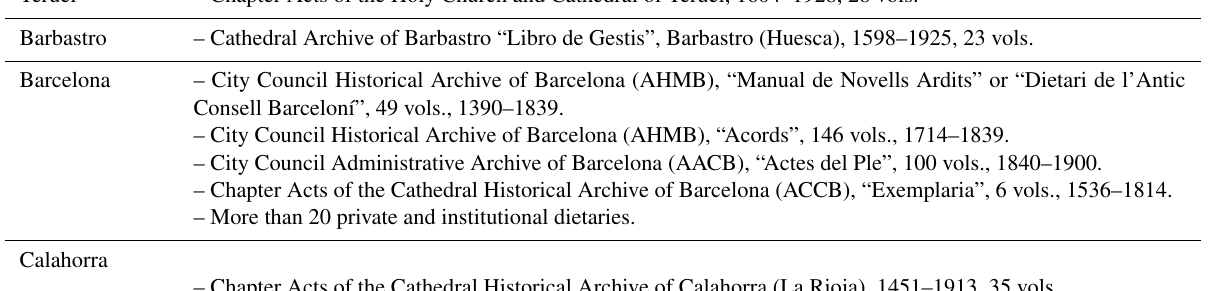
Table 2. Documentary references for administrative public documentary sources used for rogation monthly indices (all documents are generated and initialed by public notaries). Note that only the official documents are shown. Each documentary record is given a weight of reliability with the public notary rubric that acts like a secretary. This procedure is currently still in force for the same type of document, which is still generated at present